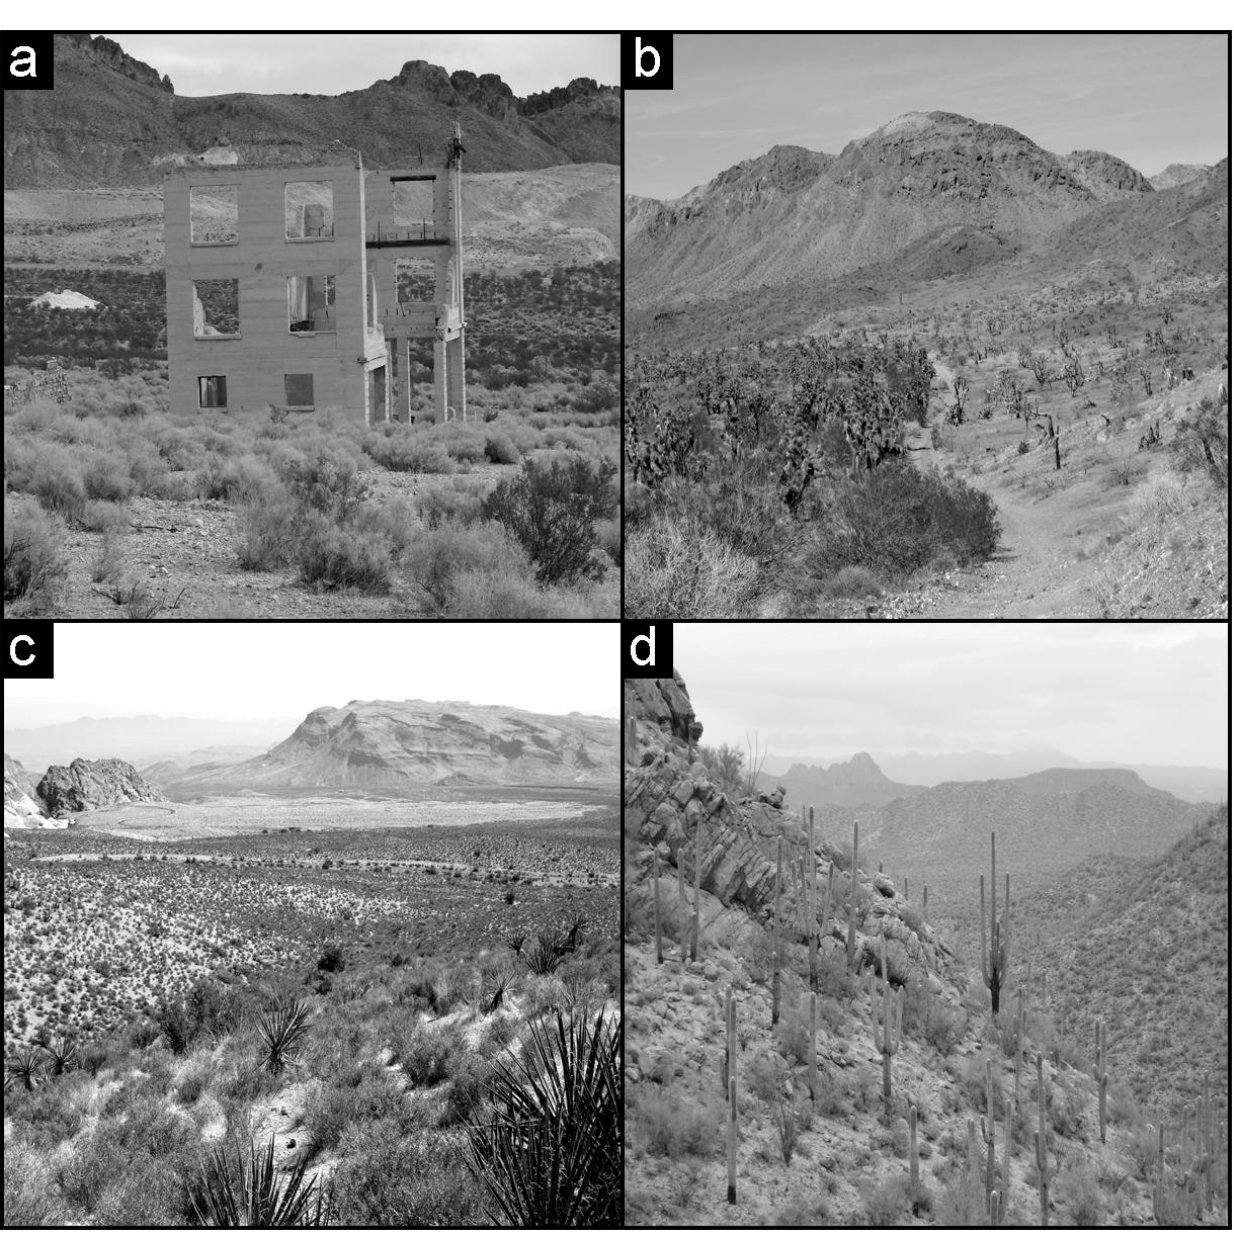
Figure 1. (a) View of part of the ghost town of Rhyolite, Nevada, in the Mojave Desert, showing distinct bands of recovering disturbed plant communities (foreground), relatively undisturbed creosote bush communities (center band of darker vegetation), and a de-vegetated band disturbed by mining in the middle-top of the photograph. (b) The 2005 Tramp Fire in the eastern Mojave Desert showing clearly demarcated burned habitat (right) and unburned Joshua tree woodland (left). (c) With its light color in the middle-top of the photo, the 2005 Loop Fire west of Las Vegas, Nevada, in the Mojave Desert illustrates the landscape-scale scars created by disturbance in the desert. (d) Example of undisturbed desert habitat containing the columnar cactus giant saguaro in the Sonoran Desert uplands of Saguaro National Park, Arizona. Photos by S.R. Abella in 2006 (a), 2007 (c), and 2008 (d), and by E.C. Engel in 2008